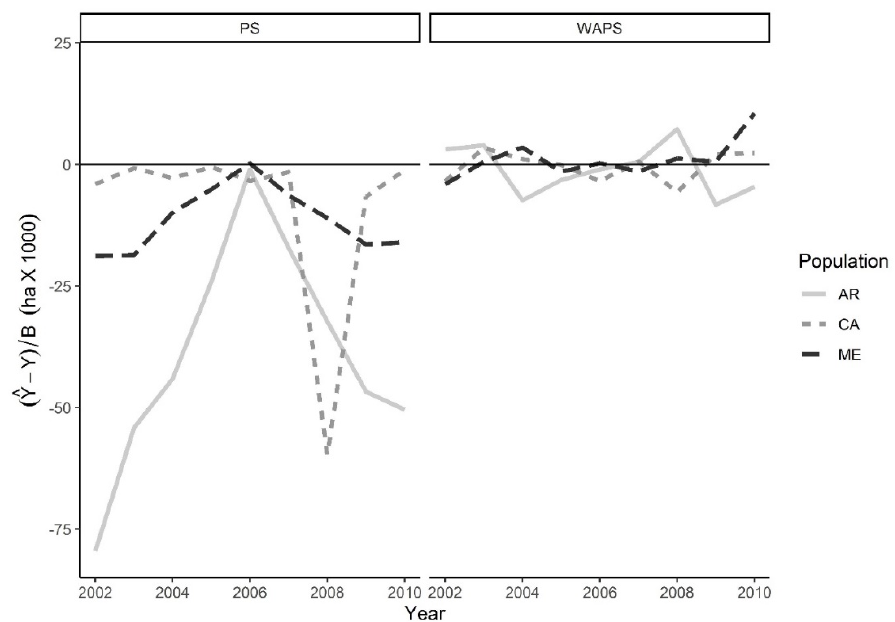
Figure 3. Bias for each estimate of the population total using the PS and WAPS method.